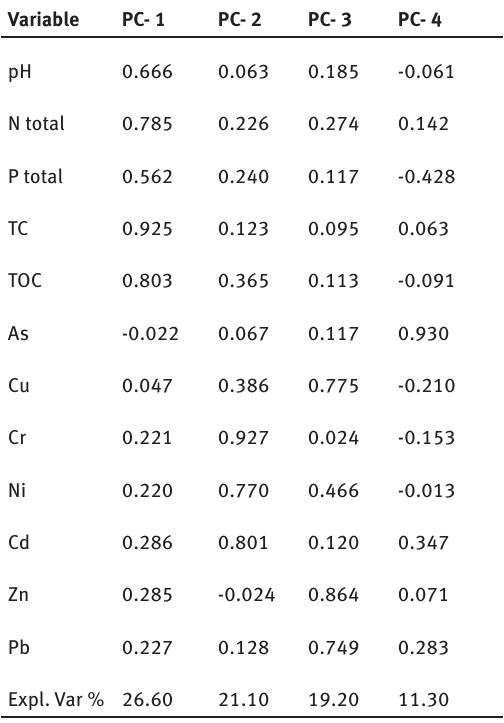
Table 3: Factor loadings (statically significant loadings are marked by